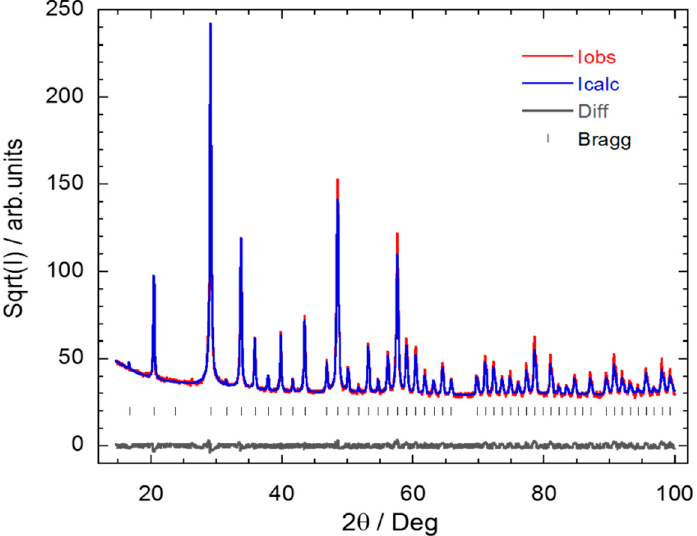
Figure 1. Rietveld refinement results on the Y 2 O 3 : Pr 3 + NCs obtained by solvothermal method at 220 ◦ C followed by calcination at 1000 ◦ C for 4 h. Only a single cubic phase (S.G. Ia 3) was used for the refinement, providing a good fitting ( R B = 3.6). No impurity phases could be detected within the experimental uncertainty. Vertical lines correspond to Bragg reflections.